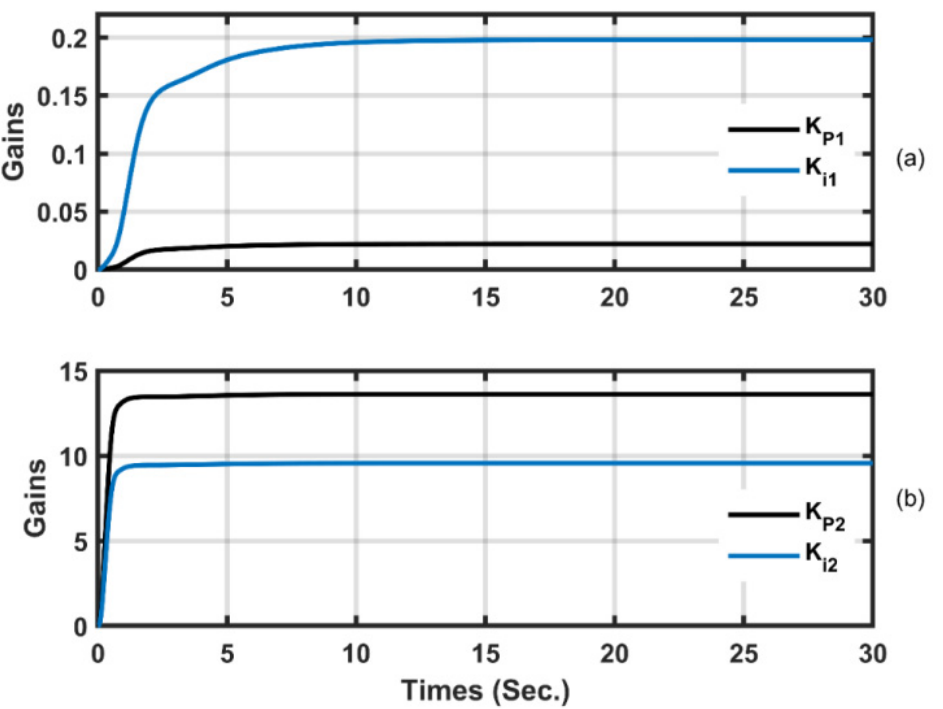
Figure 20. Tie line power deviation under disturbances in thermal and PV demands.